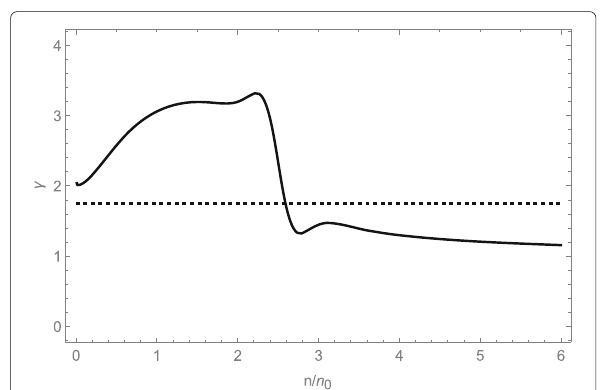
Fig. 11 Density dependence of the polytropic index γ = d ln P / d ln (cid:19)